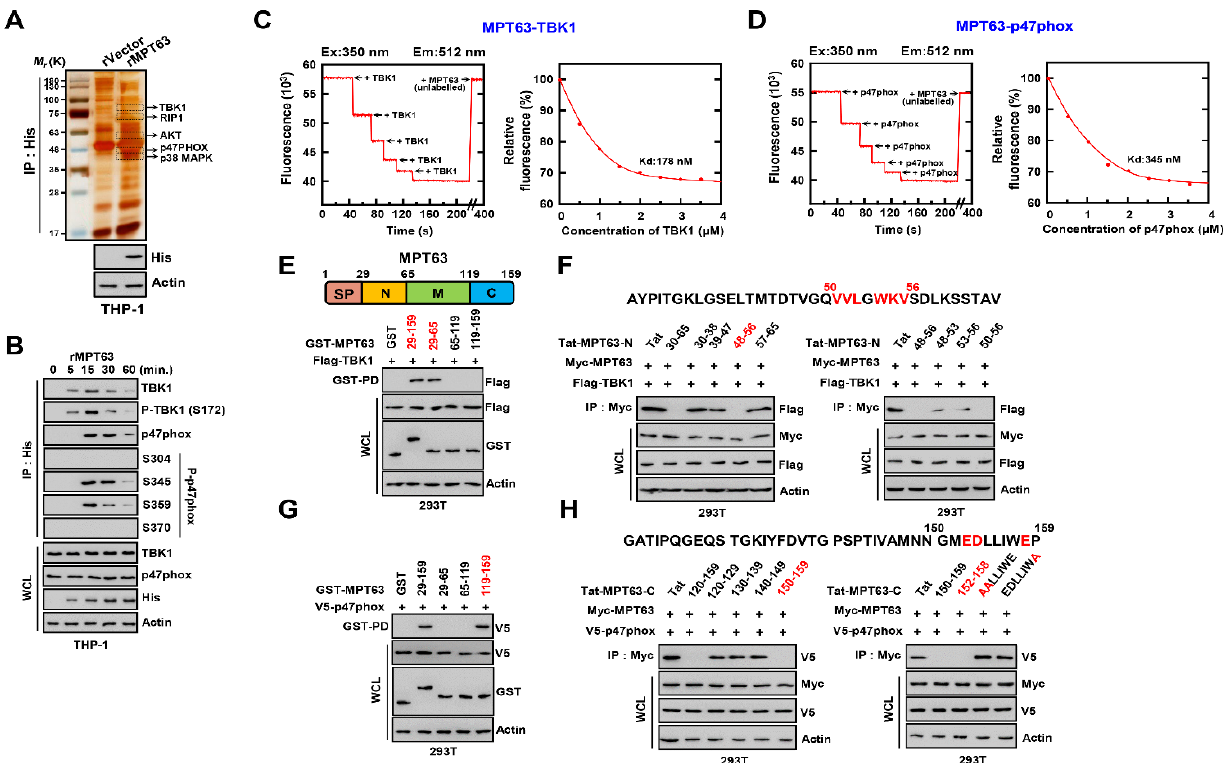
Figure 1. TBK1 and p47phox is bound with MPT63. ( A ) Identification of TBK1 and p47phox by mass spectrometry analysis in THP-1 cell lysates treated with rMPT63 or rVector. ( B ) THP-1 cells were stimulated with rMPT63 (5 μg mL −1 ) for the indicated times, followed by immunoprecipitation (IP) with αHis-agarose bead and IB with αTBK1, αP-TBK1 (S172), αp47phox, αP-p47phox (S304, 345, 359, and 370), αHis, αActin. ( C , D ) Titration of fluorescently labelled MPT63 with TBK1 and p47phox (left), with K d (178 and 345 nM) determined by curve fit analysis (right). ( E , G ) Binding mapping. Schematic diagrams of the structures of MPT63 (upper). At 48 h after transfection with mammalian glutathione S-transferase (GST) or GST-MPT63 and truncated mutant constructs together with Flag-TBK1 or V5-p47phox. 293T cells were used for GST pull down, followed by IB with αFlag or αV5. Cell lysates (WCLs) were used for IB with αFlag or αV5, αGST, and αActin. ( F , H ) 293T cells are expressing Myc-MPT63 and Flag-TBK1 or V5-p47phox and treated with several Tat-MPT63-N or MPT63-C peptides (10 µM) for 6 h, followed by IP with αMyc and IB with αFlag. WCLs were used for IB with αMyc, αFlag, and αActin. The data are representative of four independent experiments with similar results ( A – H ).